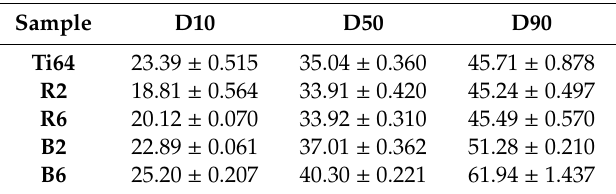
Table 2. The particle size distribution results presenting the cumulative distribution of D10, D50, and D90 for the Ti-6Al-4V (Ti64) and the developed composite